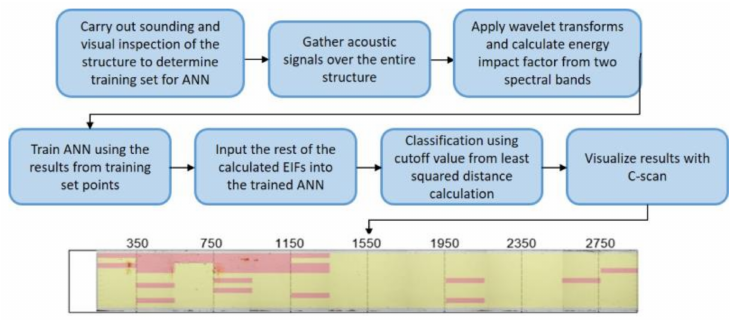
Figure 1. Schematic view of semi-automated damage